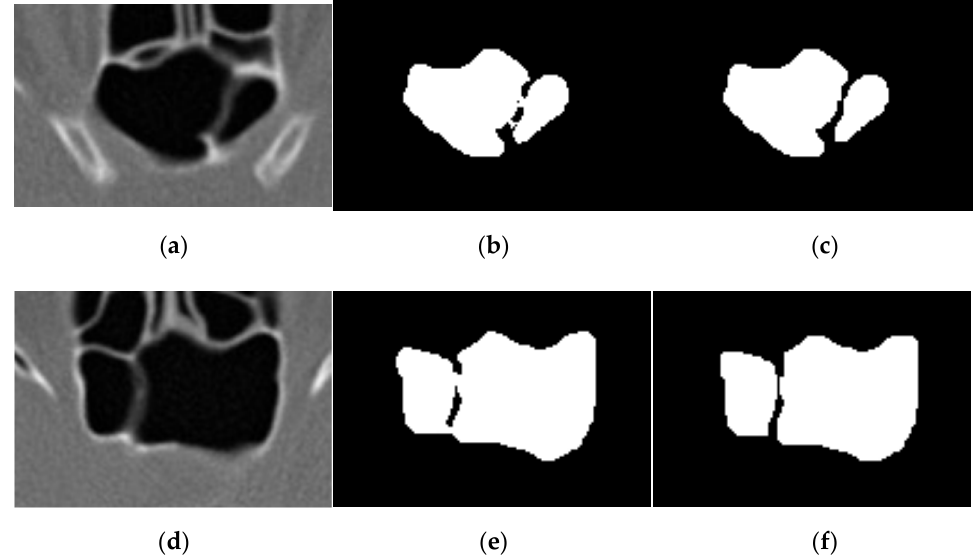
Figure 20. Schematic diagram of sphenoid sinus segmented by morphology. ( a ) Input image; ( b ) Pre- dicted image; ( c ) Morphology processed image; ( d ) Input image; ( e ) Predicted image; ( f ) Morphology processed